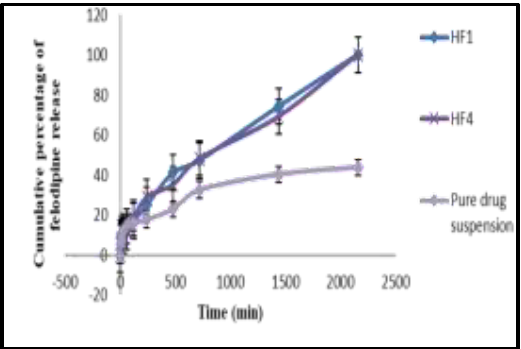
Figure 1. In vitro felodipine release profile from LPHNs formulations HF1,HF4 and the pure drug at HCl buffer pH 1.2 + 0.3 % polysorbate 80 solutions, the values of mean ±SD (n=3).